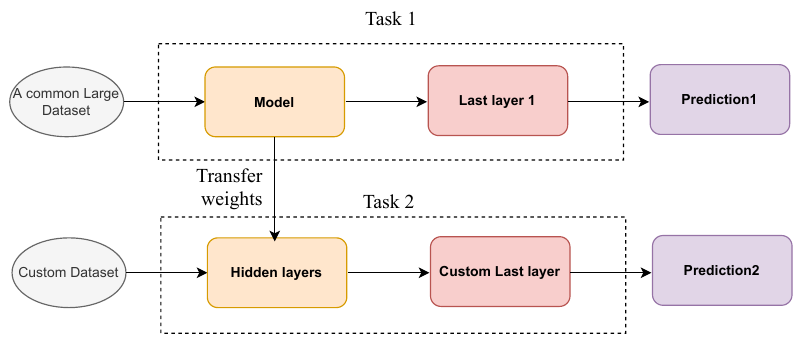
Figure 10. Transfer learning task. The weights and biases of a previously trained model are transferred to a similar model, the final layers are replaced with modified new layers, and then the model is trained with a custom